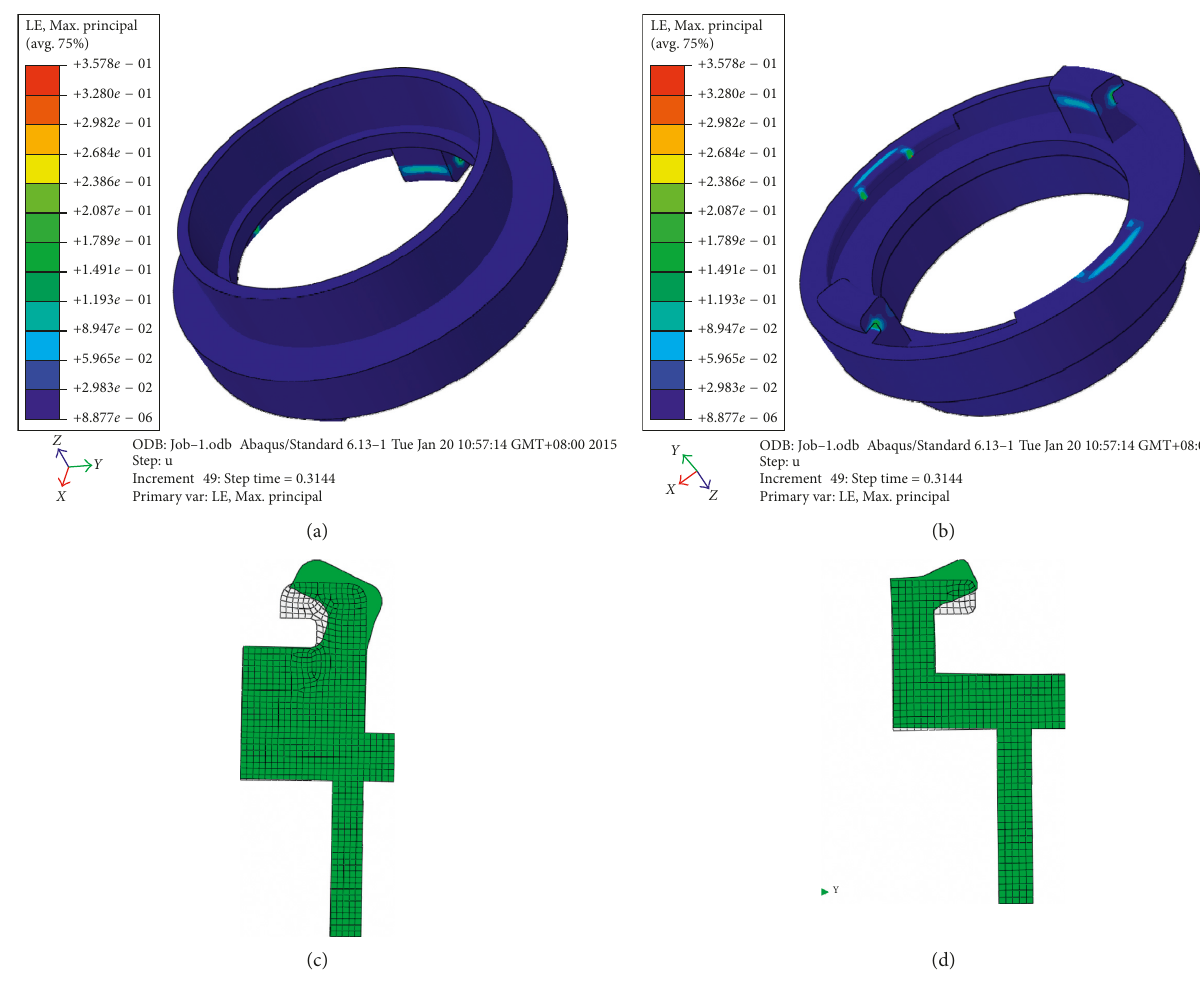
Figure 10: Deformation maps of each part of the joint. (a) Deformation map of the fixed end. (b) Deformation map of the movable end. (c) Sectional deformation diagram of the wedge-shaped part of the joint. (d) Sectional deformation diagram of the joint slot.